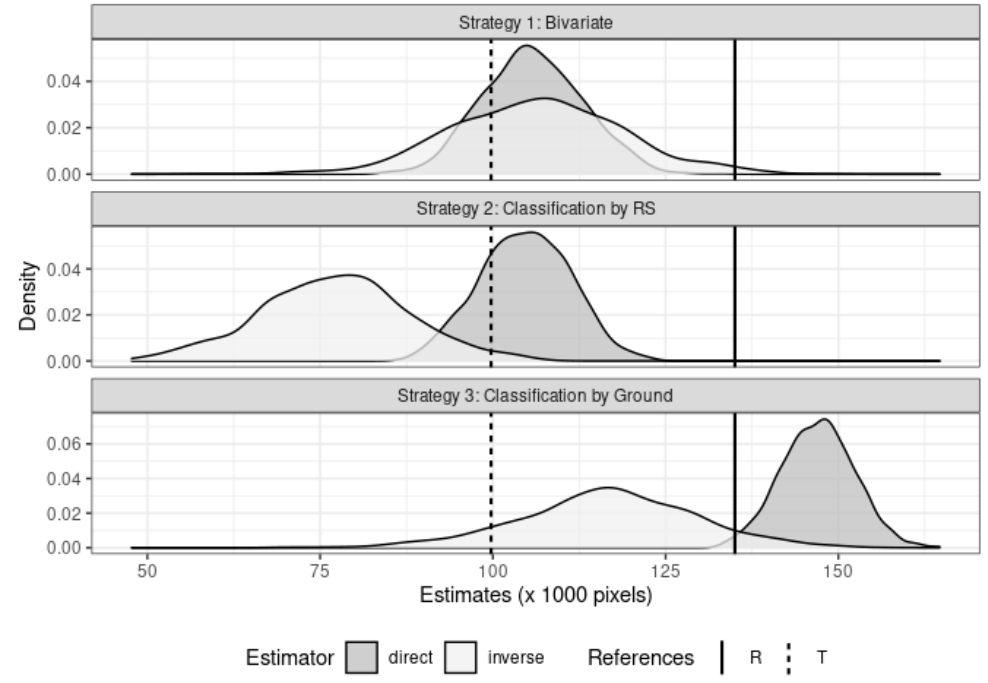
Figure 2. Bootstrap estimation for corn per strategy of selection of test points.